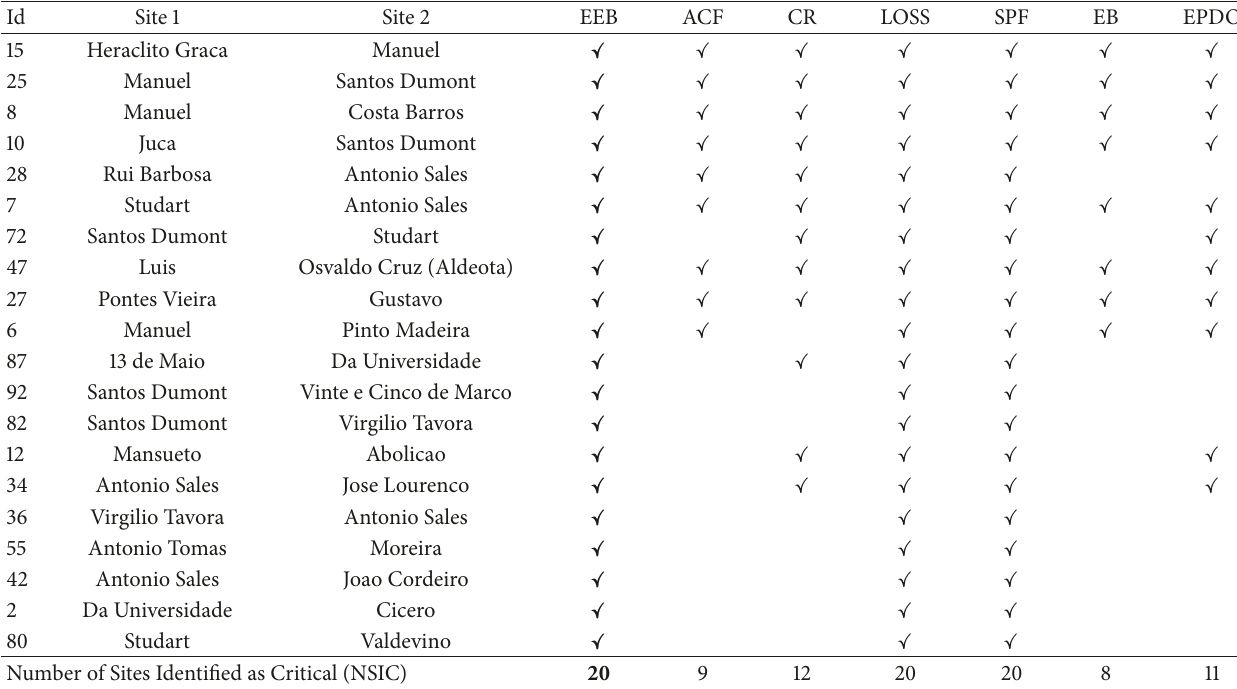
Table 4: Critical sites for EEB performance measure.